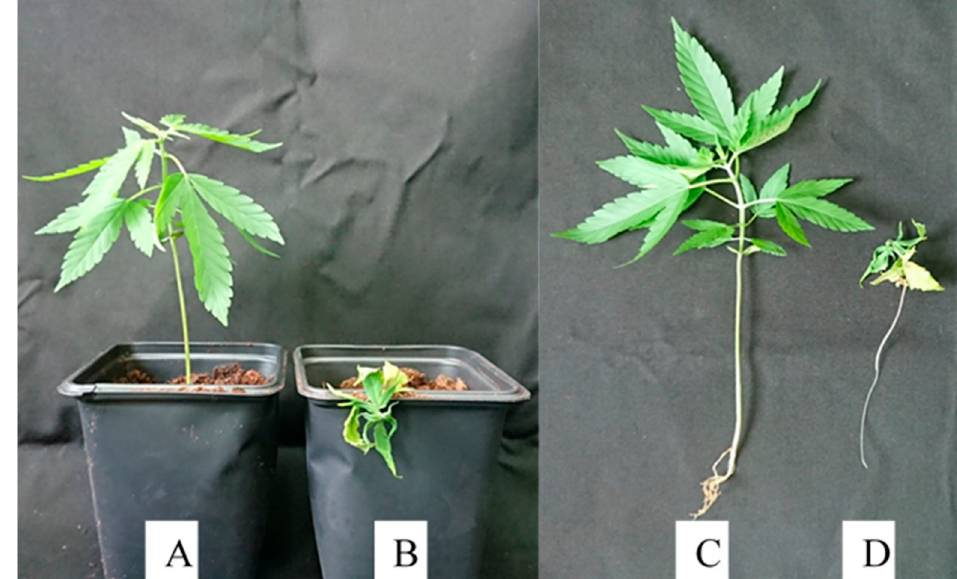
Figure 5. Inoculation of an MC seedling with ( A ) saline solution (control) compared to that inoculated with ( B ) Fusarium oxysporum (isolate 64B). Images of intact plants, including roots of ( C ) a plant inoculated with saline solution (control) compared to that ( D ) inoculated with Fusarium oxysporum (isolate 64B).